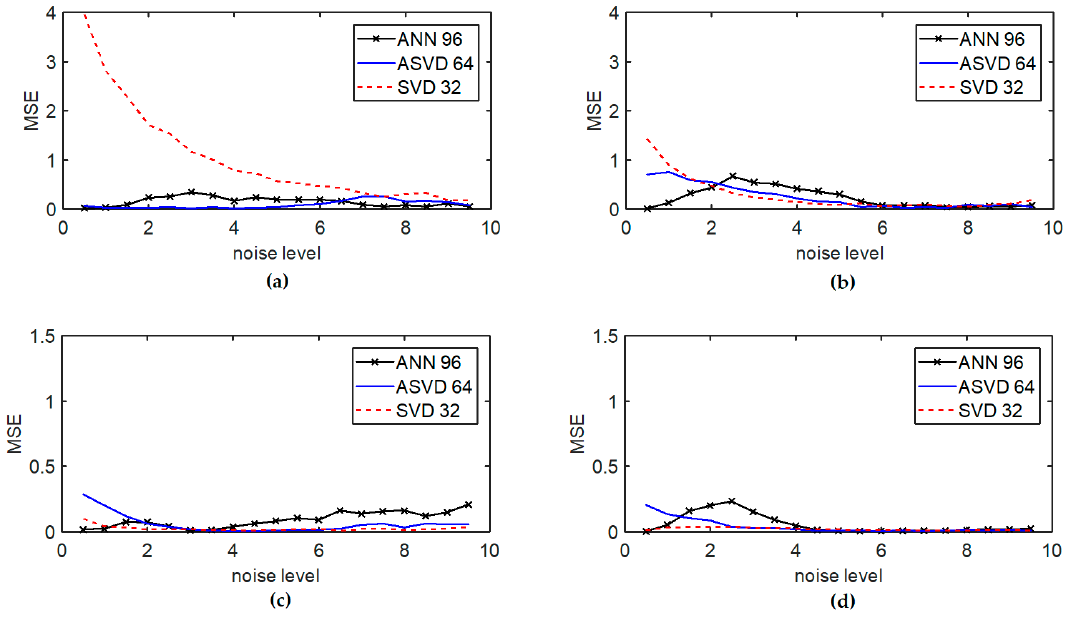
Figure 10. The MSE levels for different block-based noise level estimation algorithms in the SVD domain and for different test images: ( a ) bumpy_0129, ( b ) bumpy_0148, ( c ) marbled_0128, and ( d ) marbled_0132.